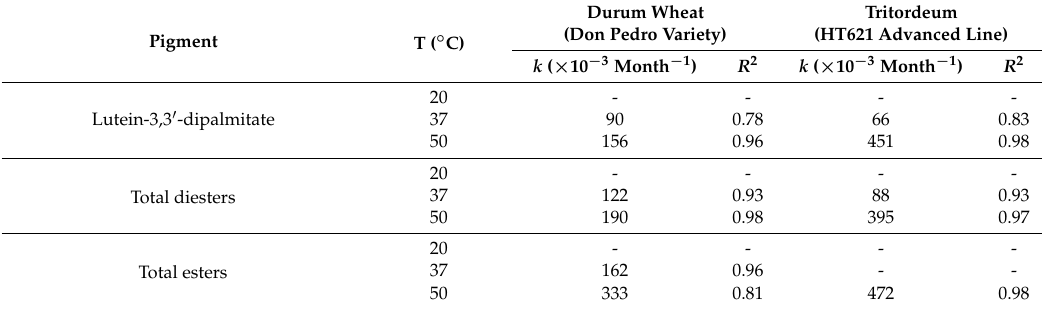
Figure S1: HPLC chromatograms obtained during long-term storage (12 months) at five different temperatures ( − 32, 6, 20, 37 and 50 ◦ C) of durum wheat (Don Pedro) and tritordeum (HT621) whole-grain flours, Table S1: Evolution of the carotenoid composition ( µ g/g dry weight) during long-term storage (12 months) of durum wheat (Don Pedro variety) whole-grain flours, Table S2: Evolution of the carotenoid composition ( µ g/g dry weight) during long-term storage (12 months) of tritordeum (HT621 advanced line) whole-grain